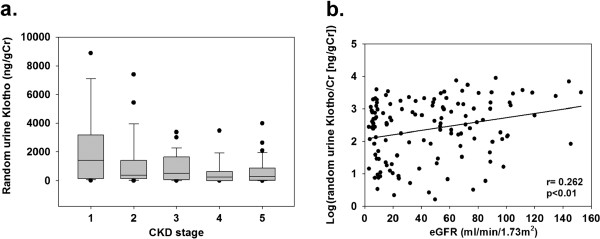
Box plots of the random urine Klotho/Cr by CKD stages and the relationship between the log-transformed random urine Klotho/Cr and eGFR. (a) No trend towards the lower values of the random urine Klotho/Cr with advancing stages of CKD was statistically confirmed. The lower border of the box and the upper border of the box represent the first quartile and third quartile, respectively. The whiskers indicate 1.5 times the IR above and below the 25th and 75th percentiles. Outliers (values >1.5 times the IR) are represented by closed circles. (b) A significant association between the log-transformed random urine Klotho/Cr and the eGFR was observed.